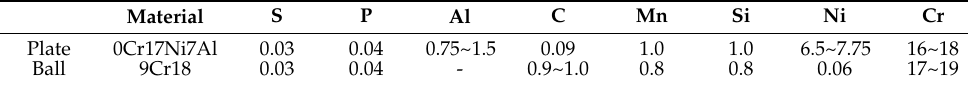
Figure 4. Surface texture disc test piece. Table 3. Chemical composition and mass fraction of friction pair.